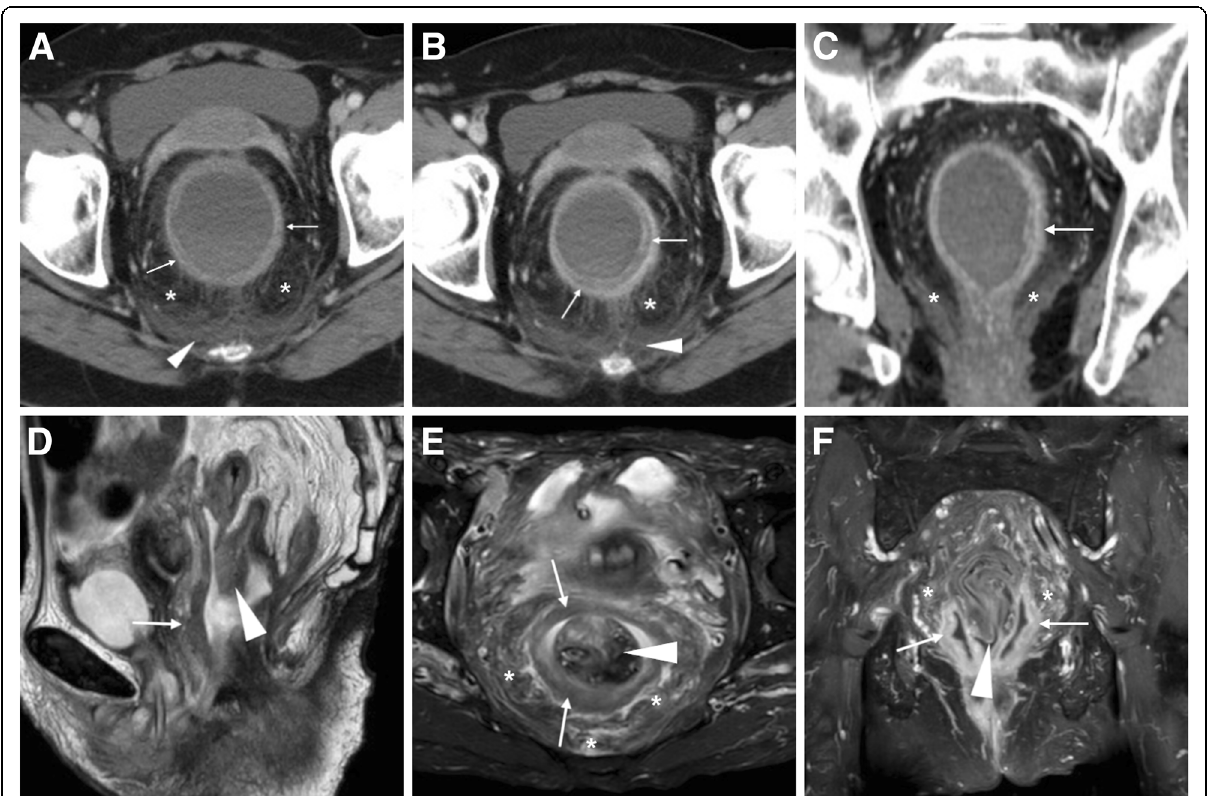
Fig. 17 Two cases of diversion proctitis. a - c ) a year after colectomy and terminal ileostomy for Crohn ’ s disease, initial CT ( a ) performed for perineal pain showed fluid-filled inflamed rectal stump with uniformly thick walls (thin arrows), mesorectal engorgement (*) and presacral fluid (arrowhead). Despite transanal drainage of fluid, repeated CT three months later ( b - c ) showed increased thickness and appearance of stratification at inflamed rectal walls (thin arrows). d - f ) following colonic resection for indeterminate colitis, MRI including sagittal T2- ( a ), fat-suppressed axial T2- and post-gadolinium fat-suppressed T1-weighted ( C ) sequences showed markedly thickened oedematous and hypervascular rectal walls (thin arrows), perirectal fluid (*) and downwards invagination of the closed apex of rectal stump